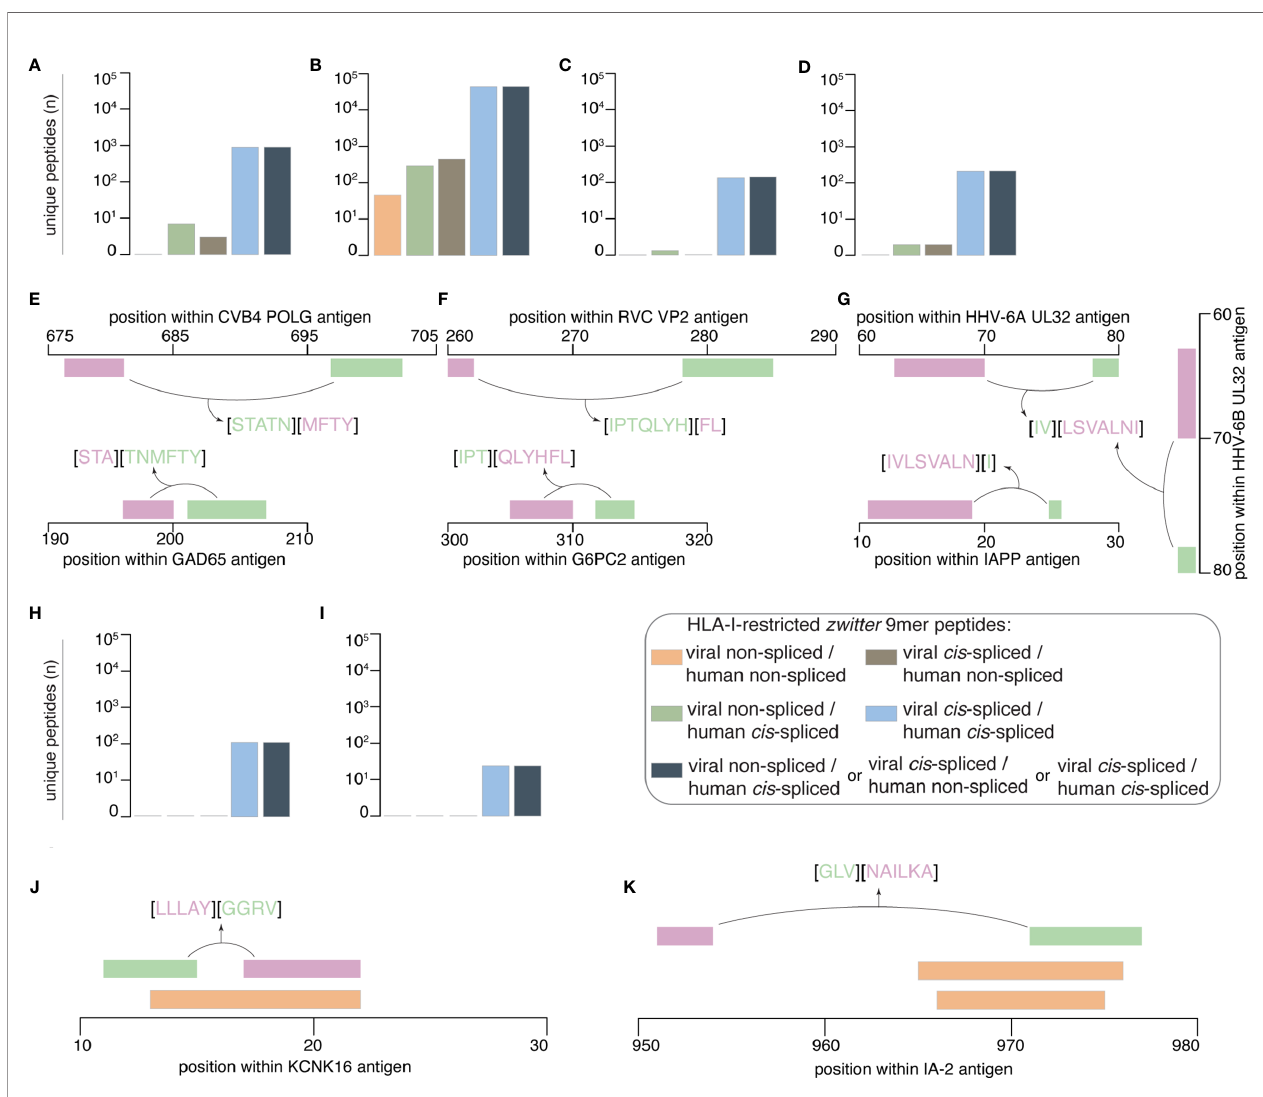
FIGURE 5 | Prioritization of viral-human zwitter 9mer peptide candidates and examples. (A – D) Number of theoretical viral-human zwitter non-spliced or cis -spliced 9mer epitope candidates predicted to ef fi ciently bind selected HLA-I variants and either (A) derived from antigens preferentially expressed in pancreatic islets over mTECs, or (B) located in hotspot regions, or (C) located in hotspot regions of antigens preferentially expressed in pancreatic islets over mTECs, or (D) derived from T1D-associated antigens preferentially expressed in pancreatic islets over mTECs. (E – G) Examples of zwitter viral-human cis -spliced epitope candidates derived from T1D-associated antigens preferentially expressed in pancreatic islets over mTECs: (E) GAD65 198-200/202-207 [STA][TNMFTY] and CVB4-derived POLG 698-702/677-680 [STATN][MFTY], (F) G6PC2 312-314/305-310 [IPT][QLYHFL] and RVC-derived VP2 278-284/260-261 [IPTQLYH][FL], as well as (G) IAPP 11-18/25 [IVLSVALN][I], HHV-6A- derived UL32 79-80/64-70 [IV][LSVALNI] and HHV-6B-derived UL32 79-80/64-70 [IV][LSVALNI] cis -spliced peptides. (H, I) Number of theoretical viral-human zwitter non- spliced or cis -spliced 9mer epitope candidates derived from T1D-associated antigens, predicted to ef fi ciently bind the selected HLA-I variants and either (H) located in hotspot regions, or (I) located in hotspot regions of antigens preferentially expressed in pancreatic islets over mTECs. (J, K) Examples of zwitter viral-human cis - spliced peptide candidates potentially associated to T1D and located in hotspots: (J) KCNK16 17-21/11-14 [LLLAY][GGRV] and (K) IA-2 951-953/971-976 [GLV][NAILKA] cis -spliced epitope candidates are located in an area where non-spliced antigenic peptides (orange bars) have been identi fi ed by mass spectrometry in HLA-I immunopeptidomes by others. In (E – G , J, K) bars ’ color code corresponds to that used in Figure 1A